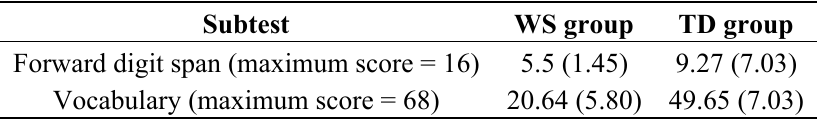
Table 3. Mean discrimination scores (SD) on the forward digit span and the vocabulary subtests of the Wechsler Intelligence Scale for Children-IV (WISC-IV). Values presented in parentheses represent standard deviations.